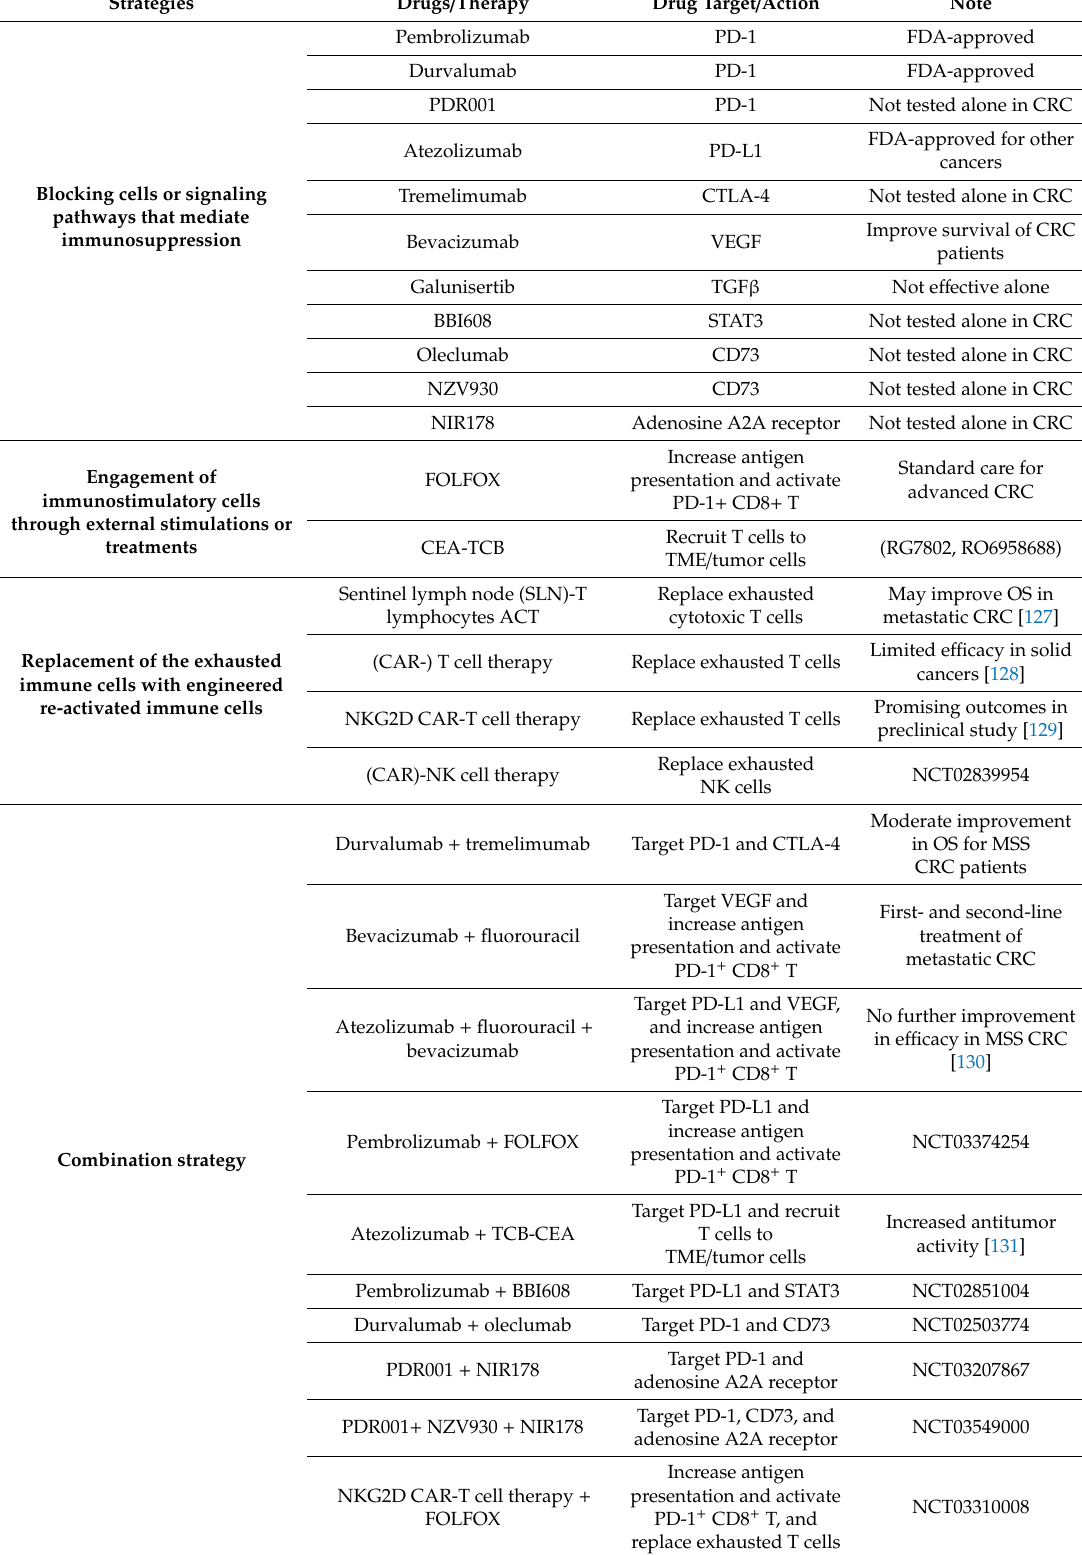
Table 2. Current strategies for immunotherapy for